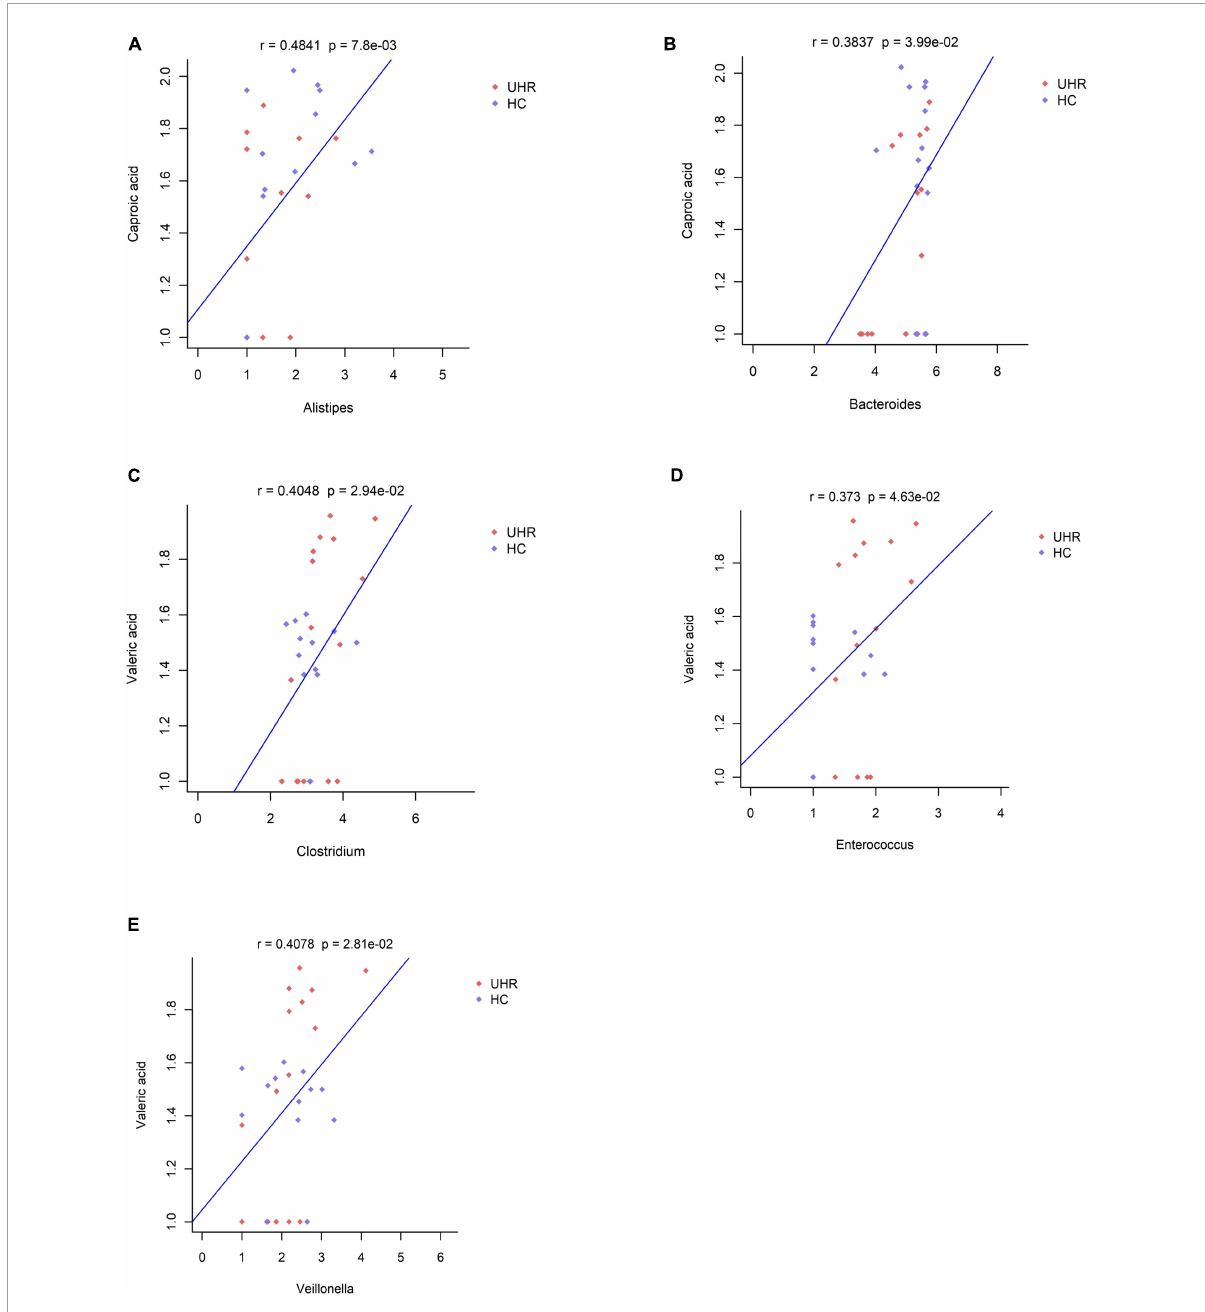
FIGURE4 Correlation between serum short-chain fatty acids (SCFAs) and the abundance of fecal Enterococcus , Clostridium , Veillonella , Alistipes , and Bacteroides genus level. (A) Showed the correlation between caproic acid level and the abundance of Alistipes. (B) Showed the correlation between caproic acid level and the abundance of Bacteroides . (C–E) Showed the correlation between valeric acid level and the abundance of Clostridium , Enterococcus , and Veillonella ,